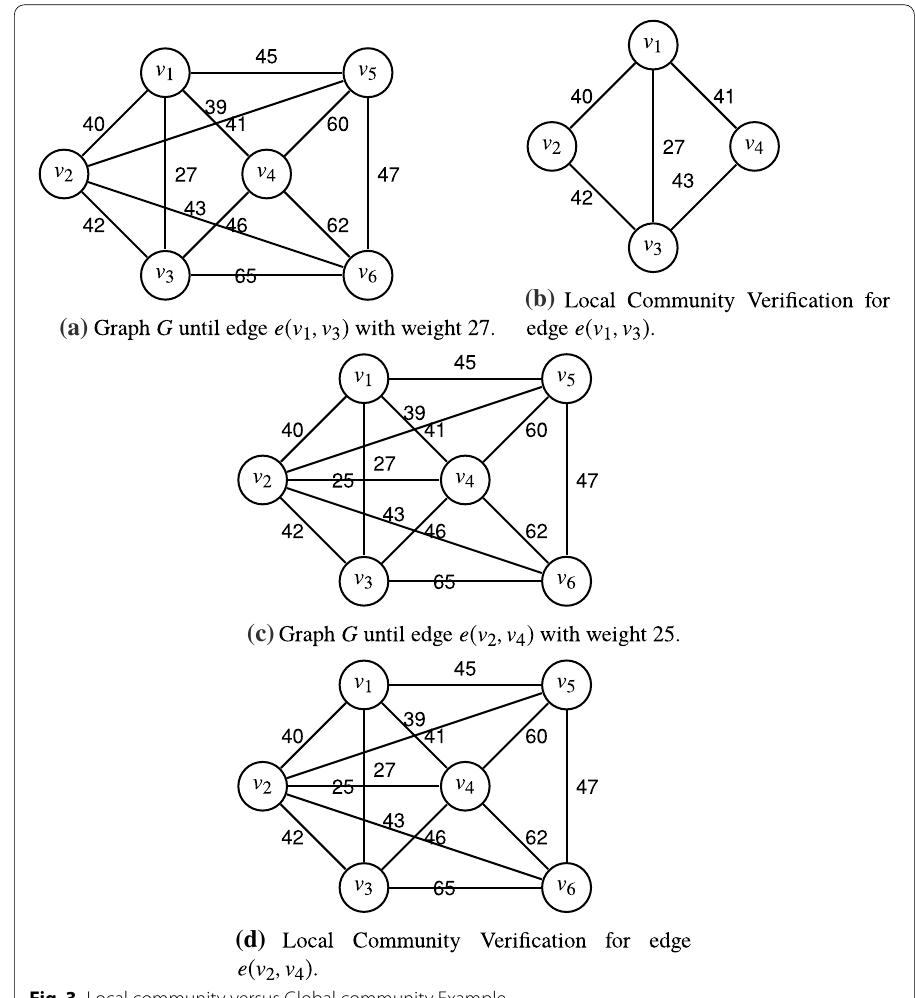
Fig. 3 Local community versus Global community